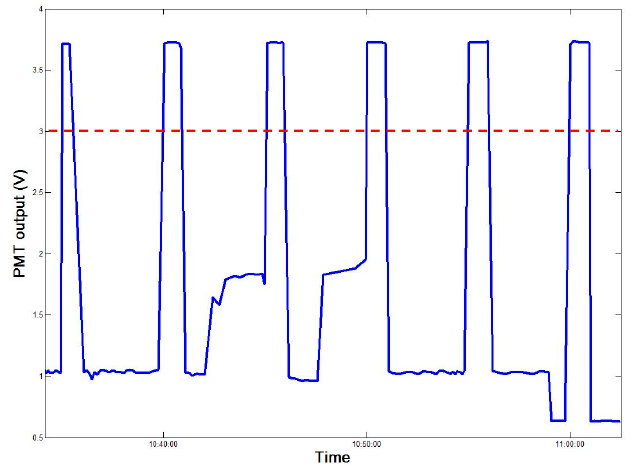
Figure 10. PMT recorded for the six oil types in sequential oil-spill simulations.